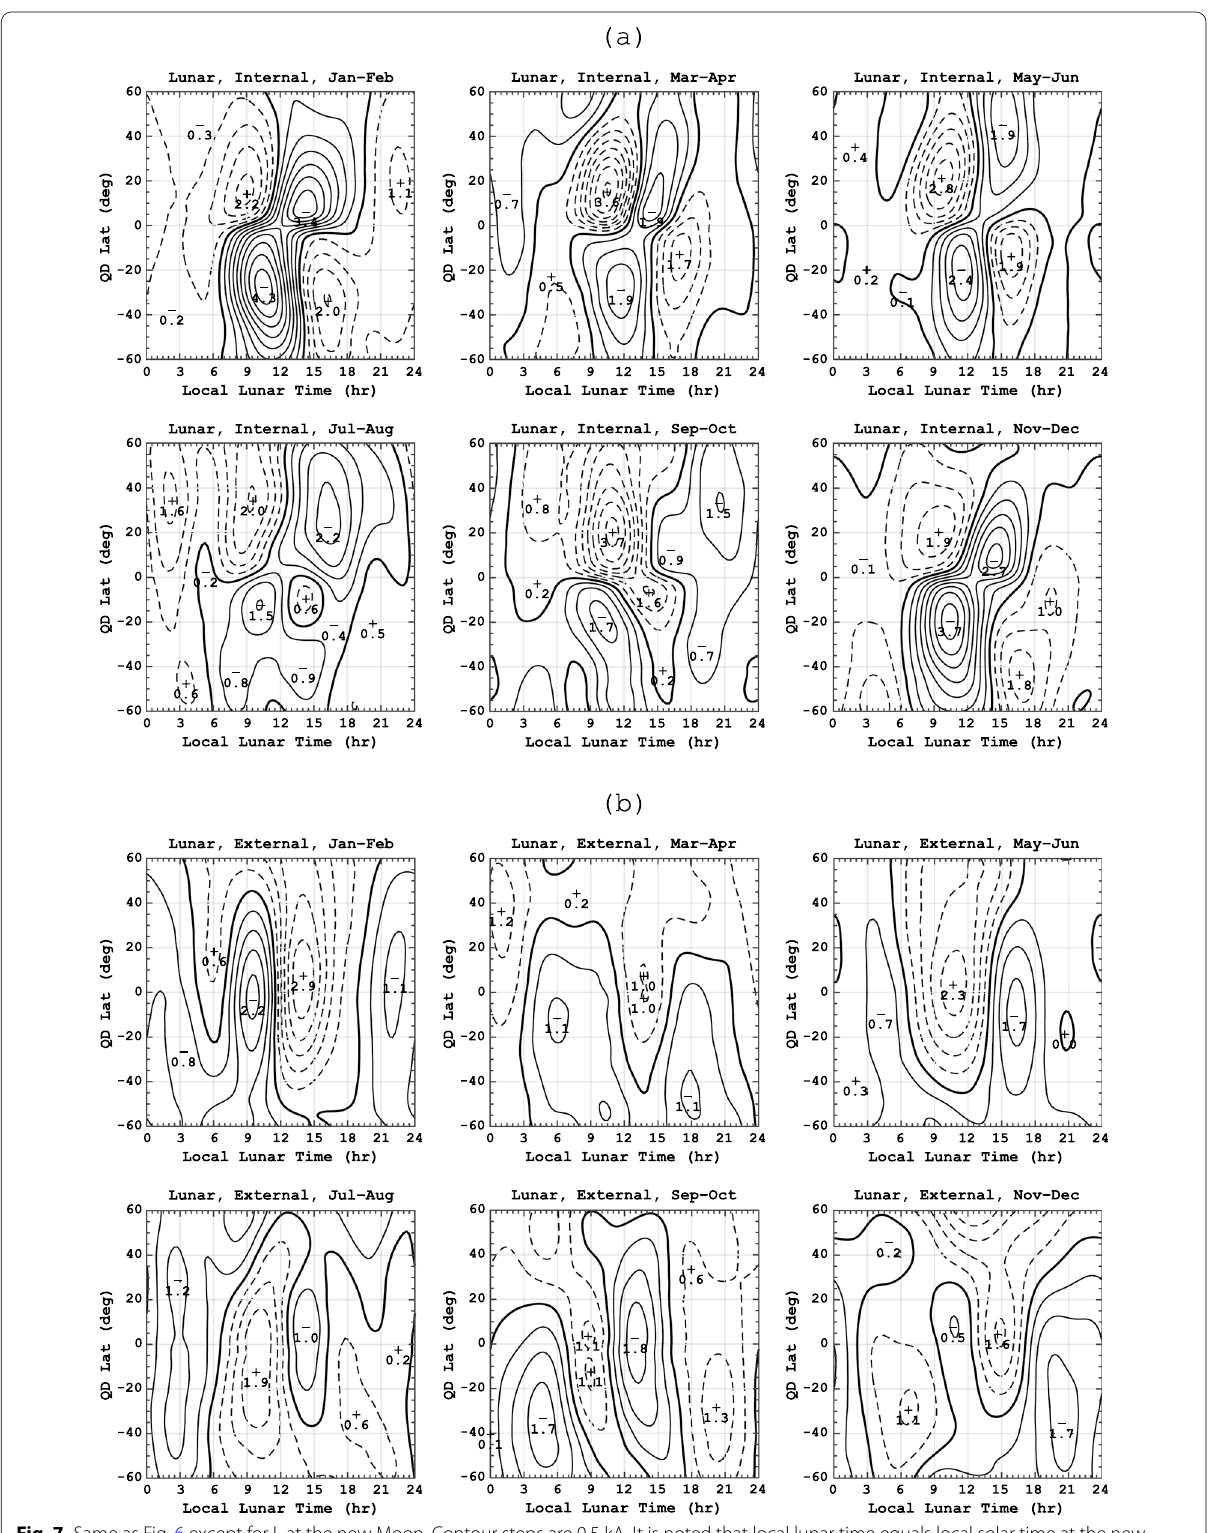
Fig. 7 Same as Fig. 6 except for L at the new Moon. Contour steps are 0.5 kA. It is noted that local lunar time equals local solar time at the new